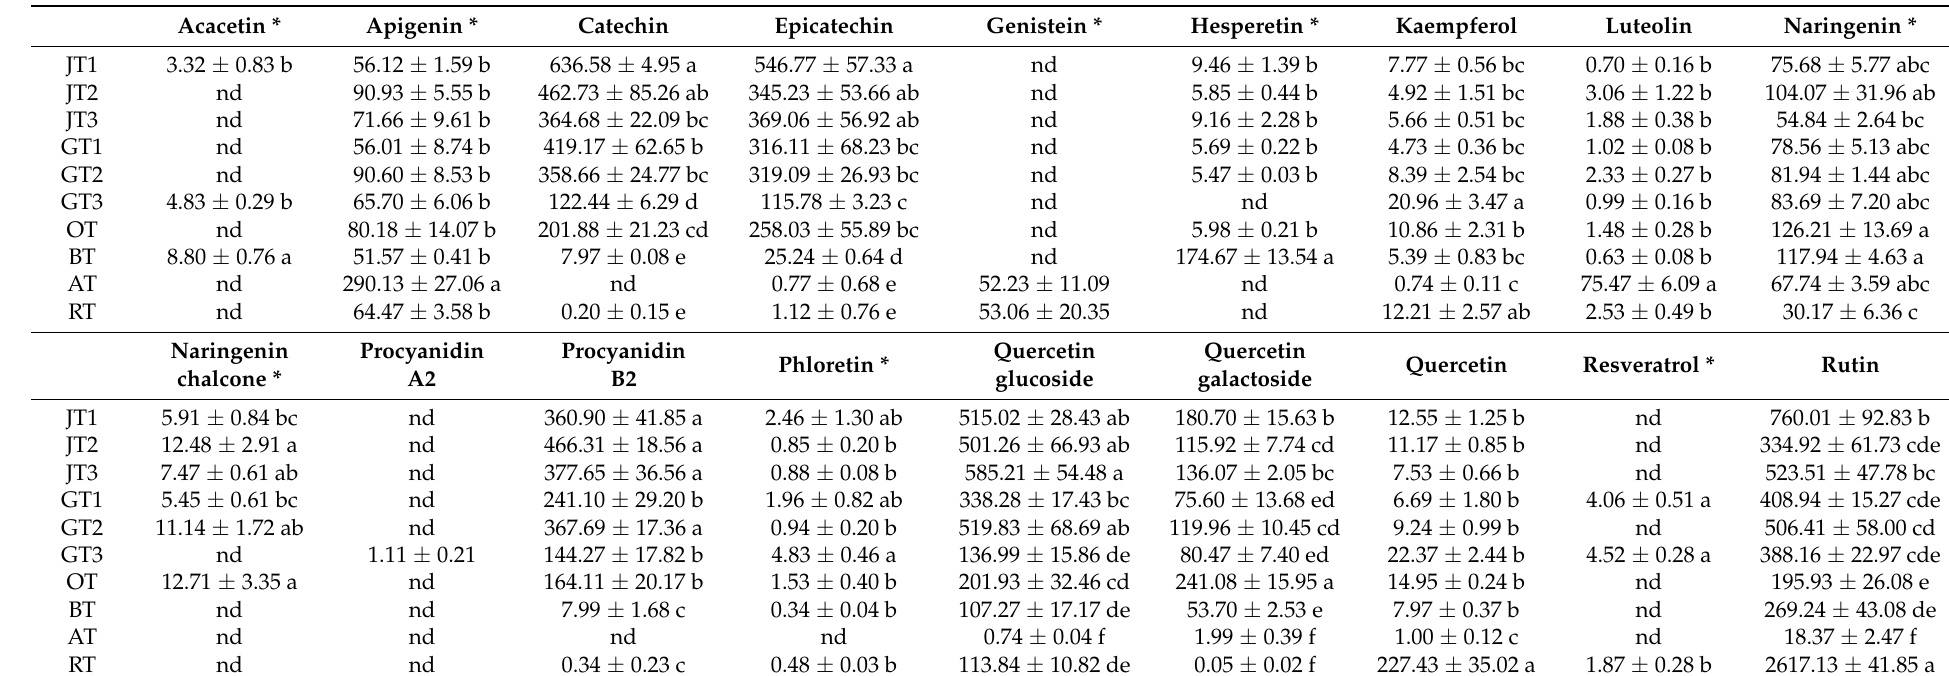
Table 2. Flavonoids ( µ g/g) in the studied